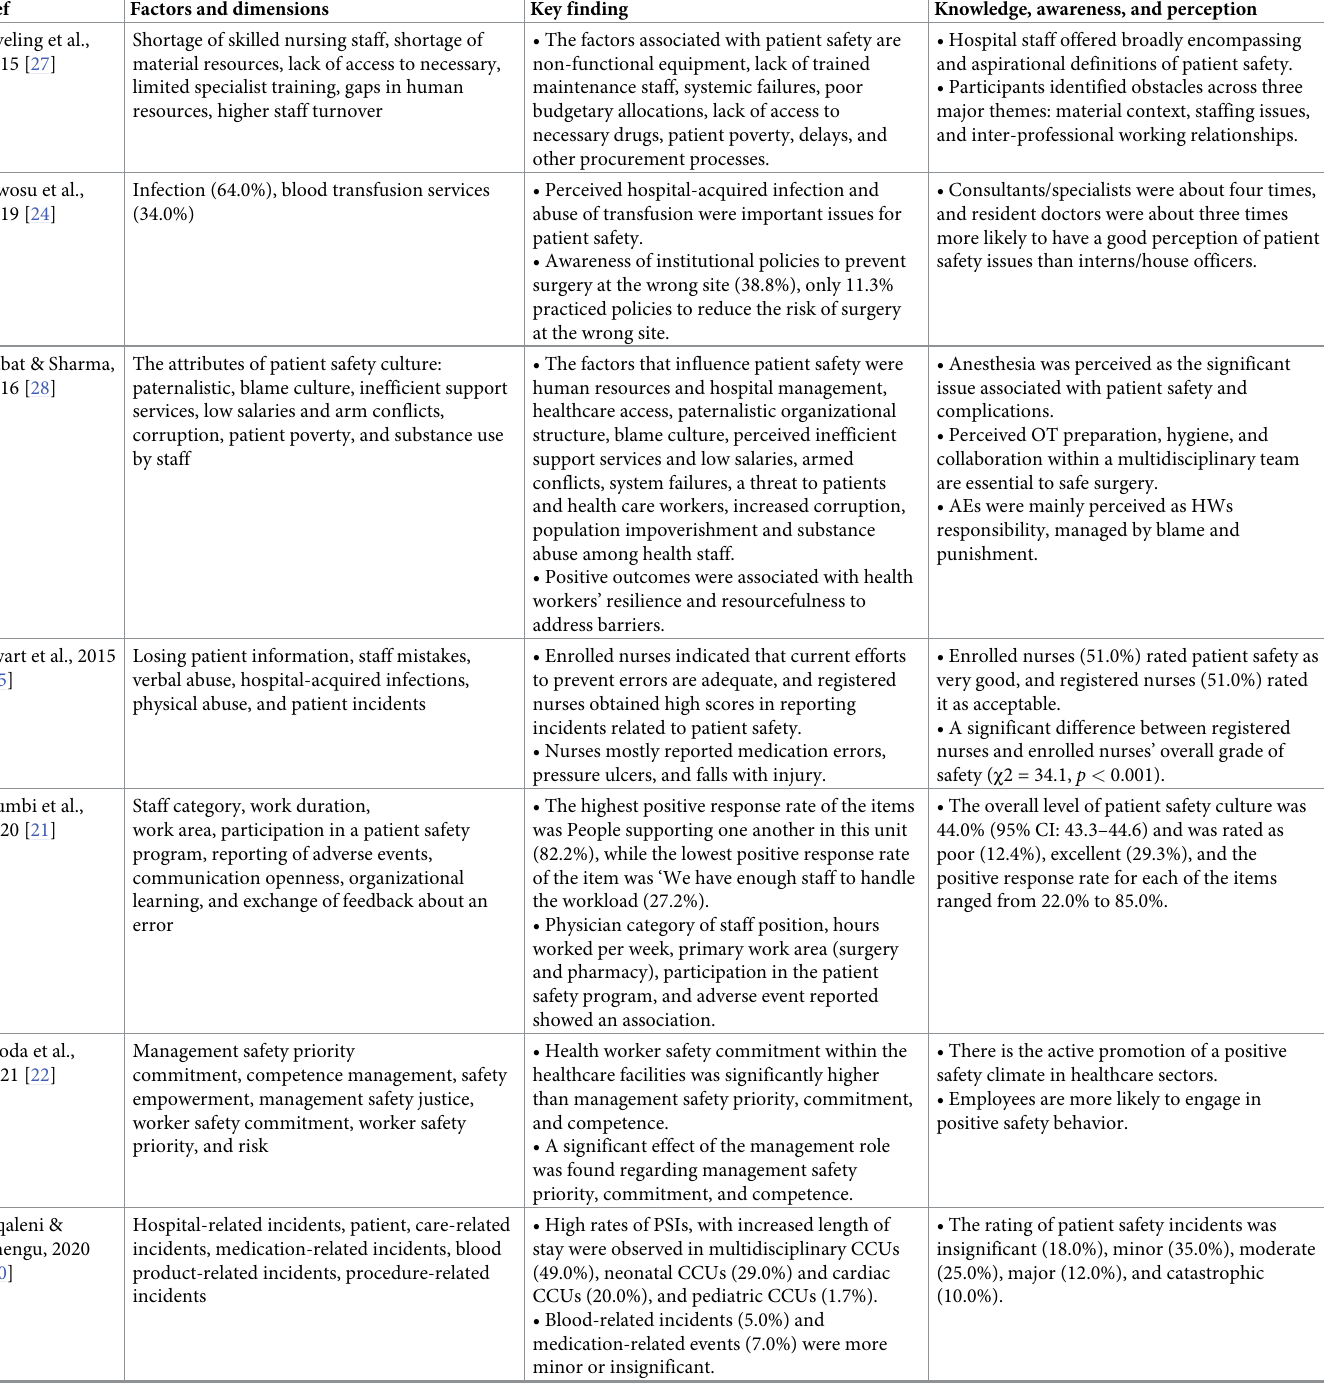
Table 2. Distribution of factors affecting patient safety and key